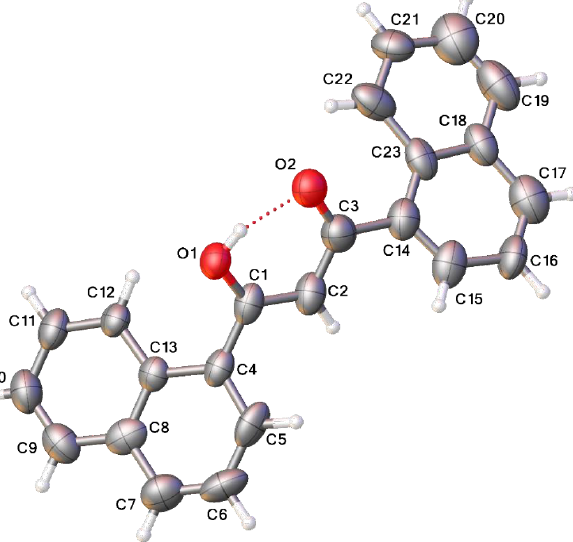
Figure 2. View of the asymmetric unit of in the HL 2 crystal structure. The thermal ellipsoids are shown at 50% probability.